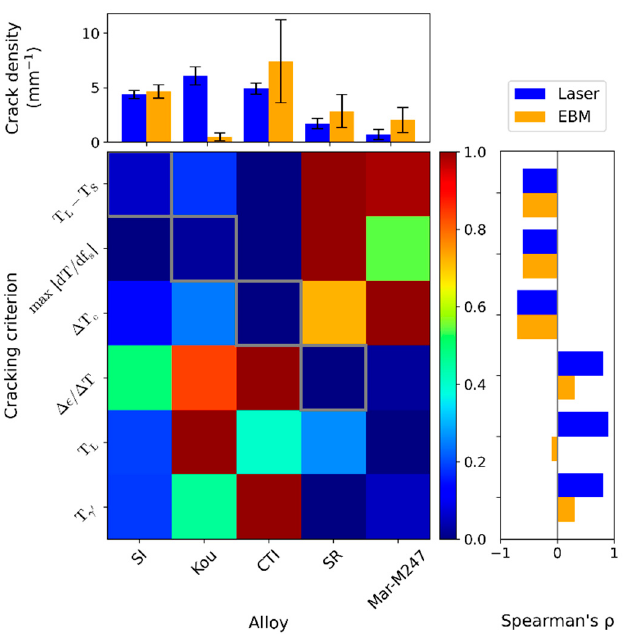
Figure 8. Correlation analysis of experimentally determined crack densities with calculated, nor- malized cracking criteria. T L -T S , solidification interval; max |dT/df s | , Kou criterion; ∆ T/ ∆ f s , critical temperature interval; and ∆ ε / ∆ T , shrinkage